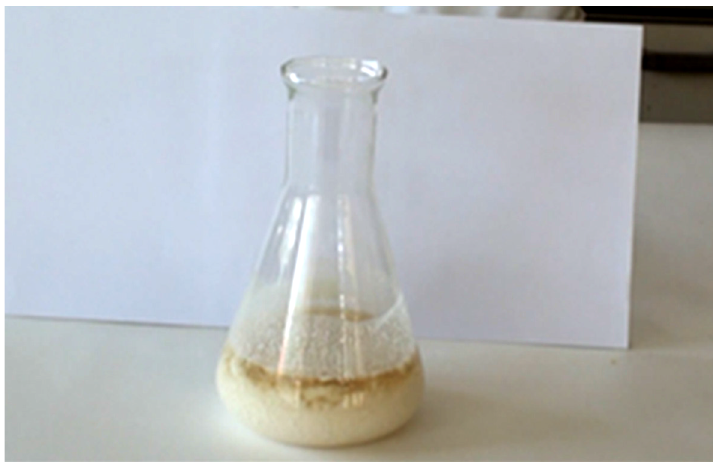
Figure 3. The milk is separated into two